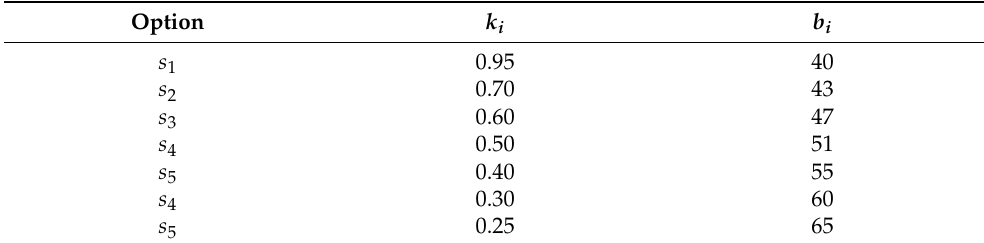
Table 2. Available emergency replenishment